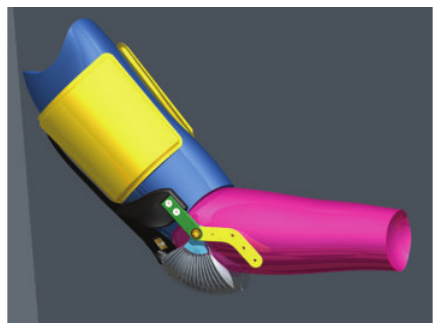
Figure 3: Inflatable shell structure.